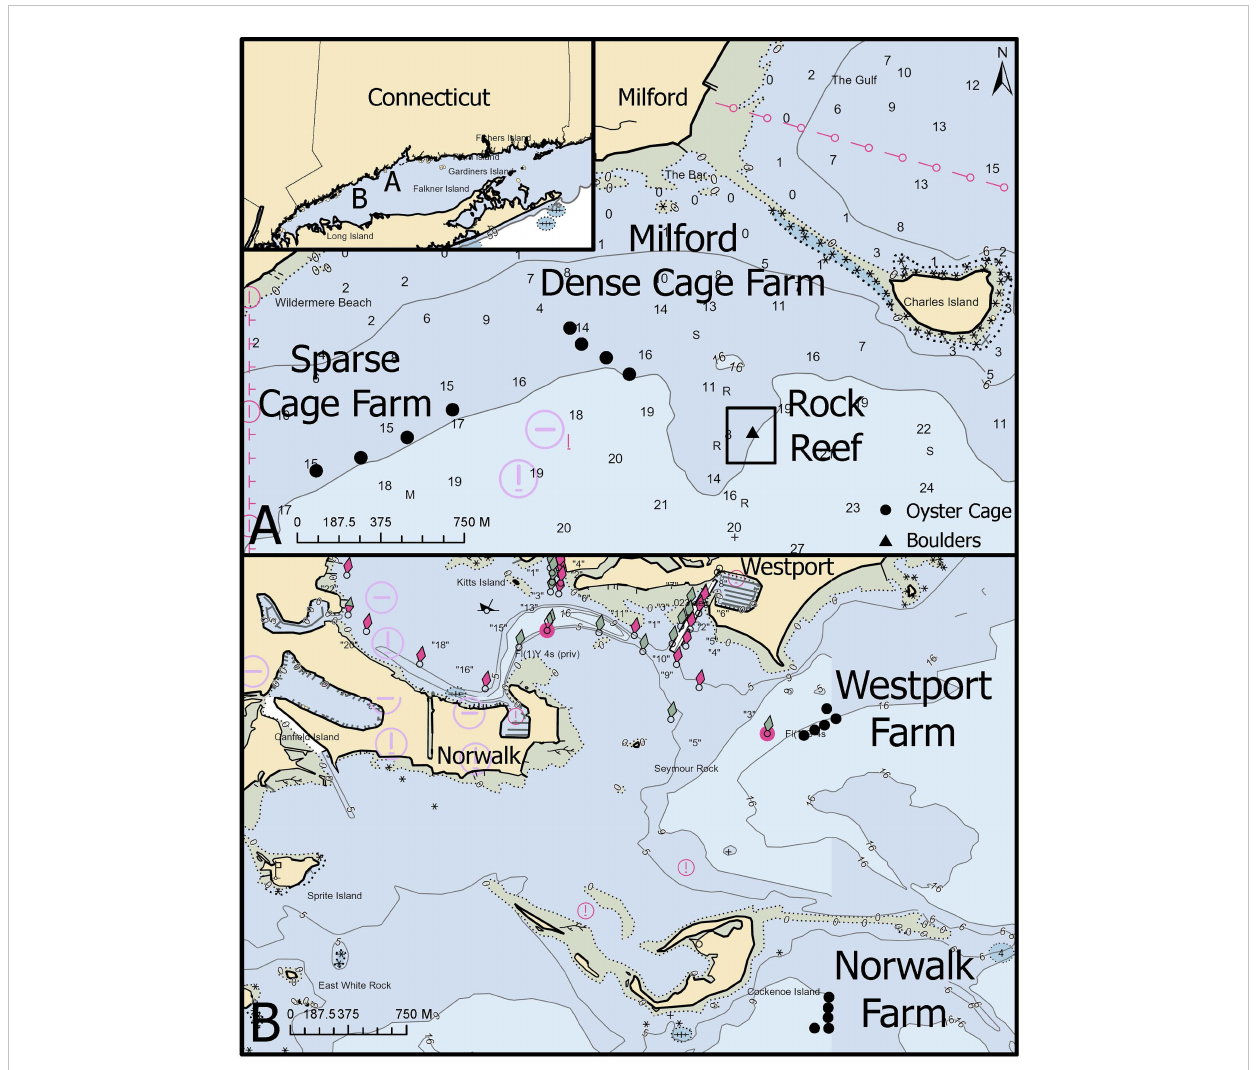
FIGURE 1 Map of study sites, including cages placed at dense and sparse farms, a rock reef, and three commercial shell fi sh farms. Inset map shows location of sites within Long Island Sound, USA. Symbols indicate the placement of individual cages or boulders with adjacent T-platform stands; the four t-platform stands at the rock reef site could not be delineated at this map scale. Numbers indicate water depth in meters. (A) Sites within a single embayment near Milford, CT, included a natural cobble and boulder rock reef (rock reef), 5 single cages (sparse cage farm), and cages deployed adjacent to a commercial oyster farm (dense cage farm). The rock reef and sparse cage farm sites were only sampled in 2018; the dense cage farm location was sampled in both 2018 (dense cage farm) and 2019 (Milford farm). (B) Two additional farms were sampled in 2019 (Norwalk and